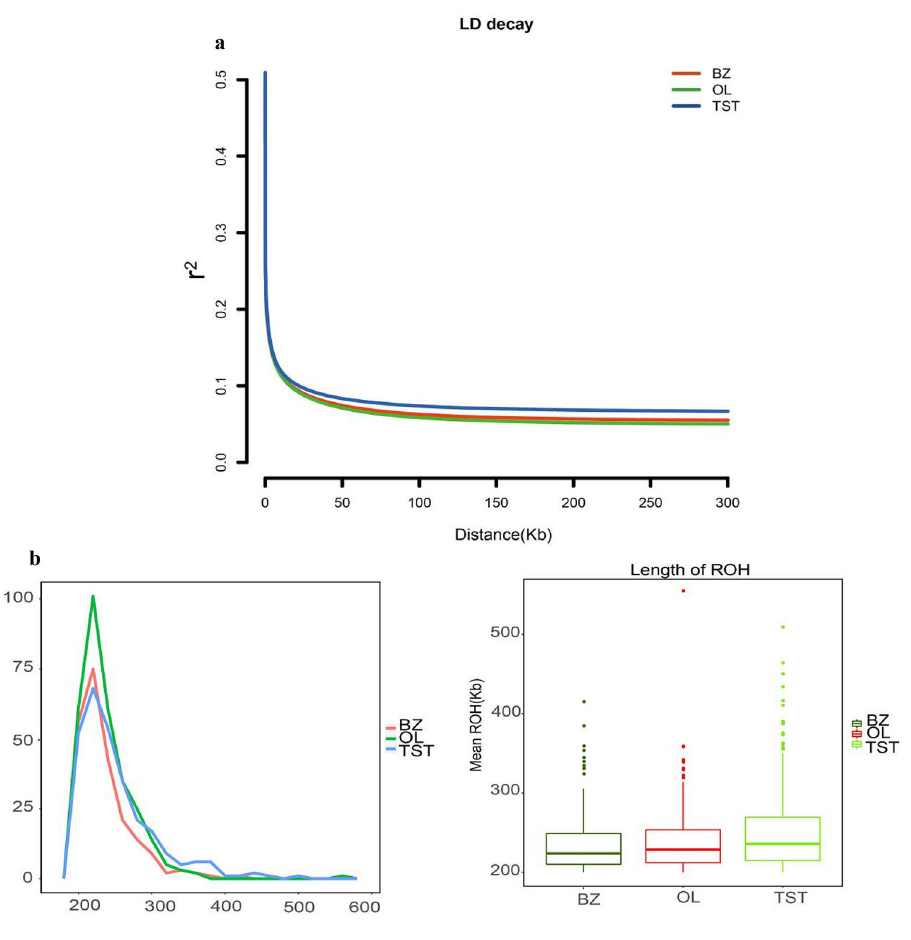
Figure 2. The population genetic and demographic dynamics of each Sheep breed. ( a ) Decay of linkage disequilibrium (LD) in the Chinese native sheep breeds, with one line per breed. ( b ) The length and distribution of ROH provide information regarding.